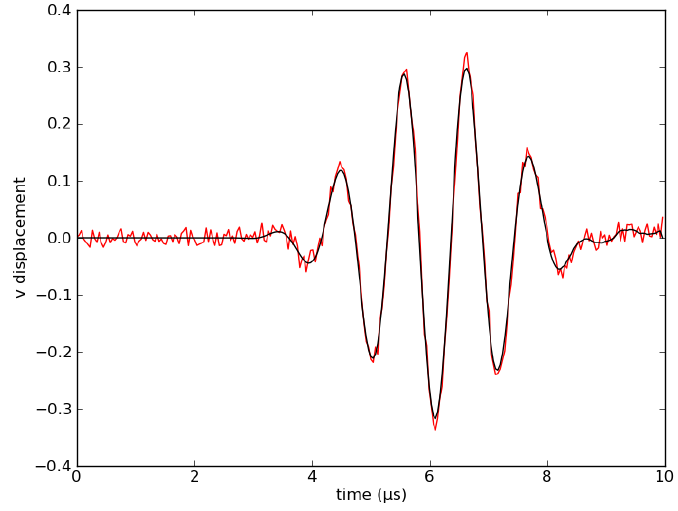
Fig. 10. Target signal (red line) compared with reconstruction by LISA